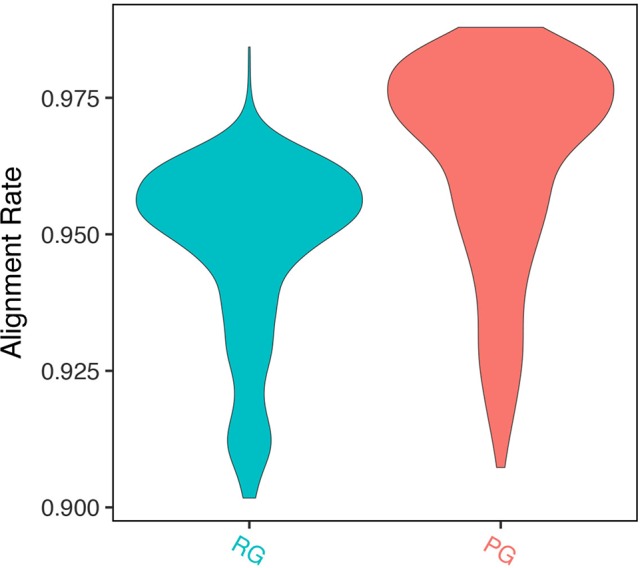
Alignment rate of RNA-seq read to pseudo-genome (PG) sequence and Col-0 reference genome (RG) sequence.